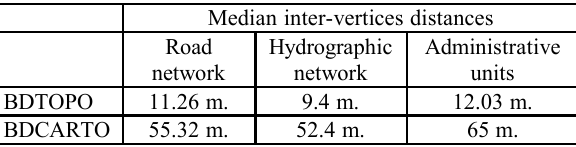
Table 1. Median inter-vertices distances of three objects